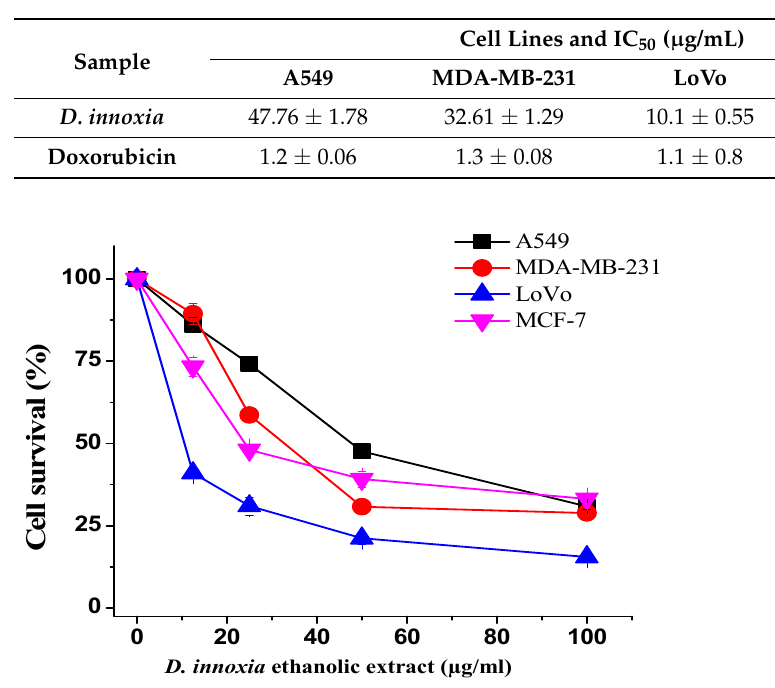
Figure 1. Cytotoxic effect of D. innoxia ethanolic extract on various cancer cell lines after 48 h of exposure. Cells were treated as described in the Methods section and cell viability was determined using the MTT assay. Data are expressed as the mean + standard deviation of three experiments.